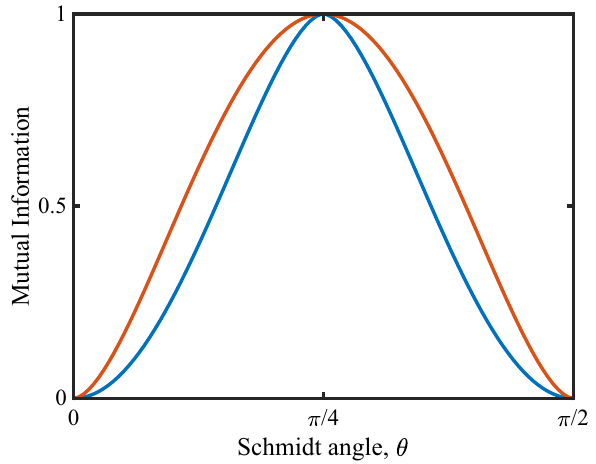
Figure 3. Mutual information as a function of the Schmidt angle θ . The red curve represents the entropy of entanglement and the blue curve represents the upper bound to EA when Alice choose to measure in the σ x basis for pure states. For pure states, quantum discord reduces to